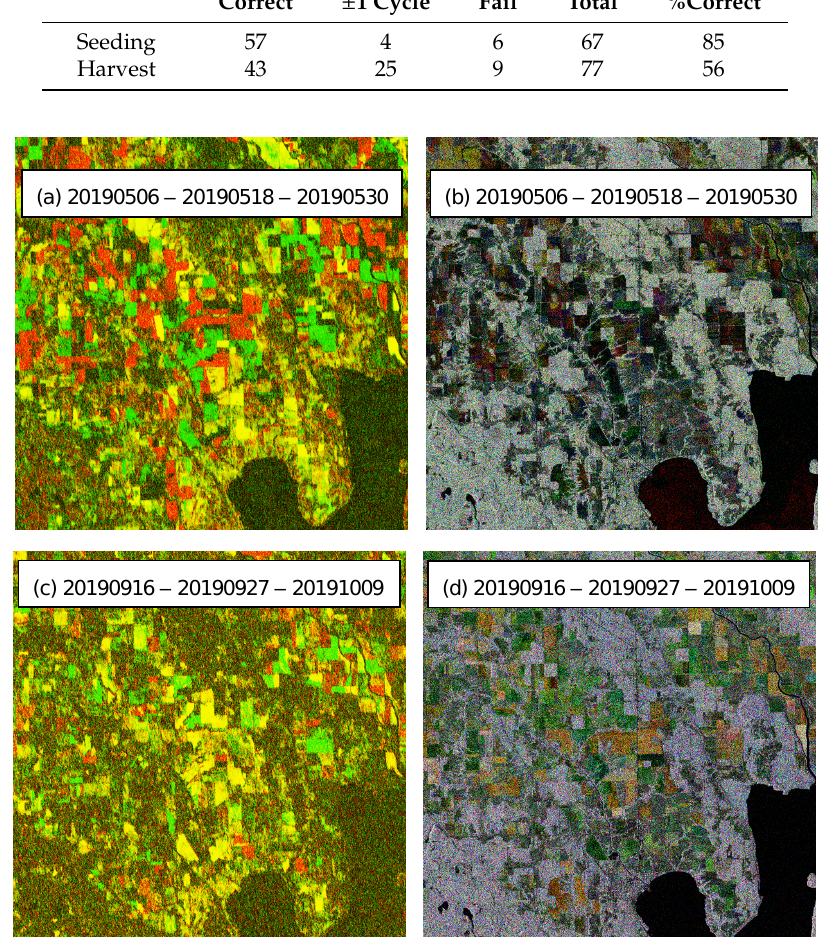
Figure 8. Mapping of change through InSAR coherence at the start May 6–May 18–May 30 ( a,b ) and end lower, September 15, September 27, and October 9 ( c,d ) of the season. Maps to the left are generated using two consecutive InSAR coherence images and one blank image as RGB channels ( a,c ), and maps to the right are made using the three VH backscattering intensity images sequentially as RGB channels ( b,d ).